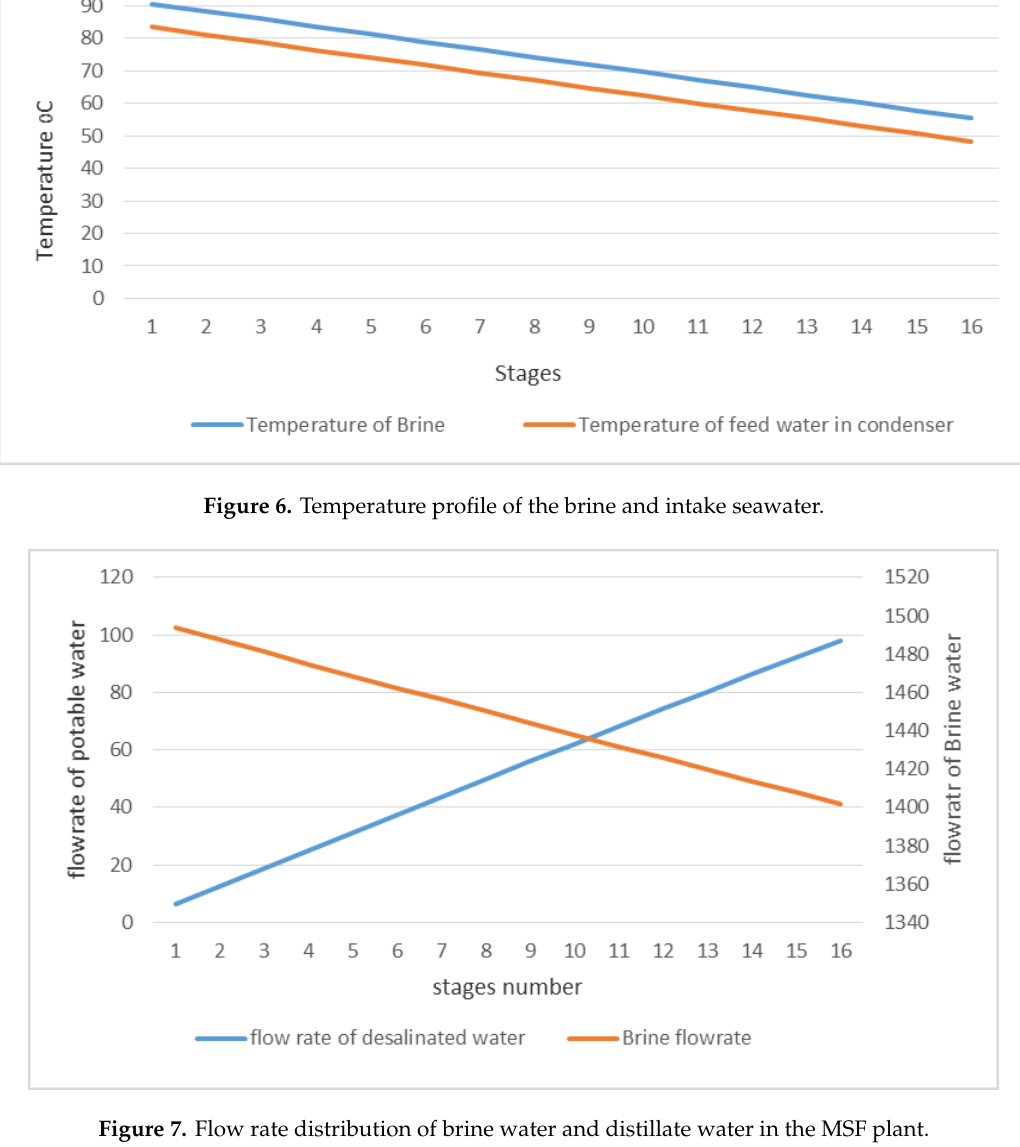
Figure 7. Flow rate distribution of brine water and distillate water in the MSF plant.